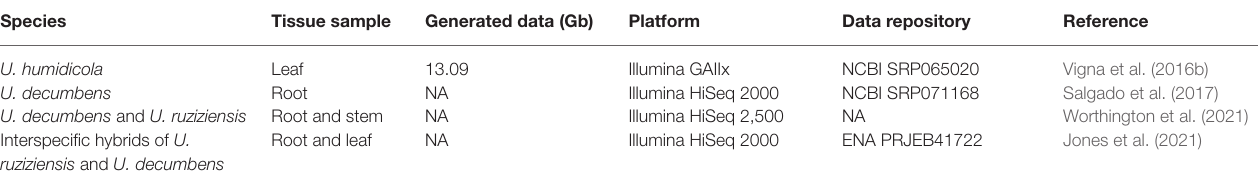
TABLE 6 | Details of transcriptome sequences of Urochloa